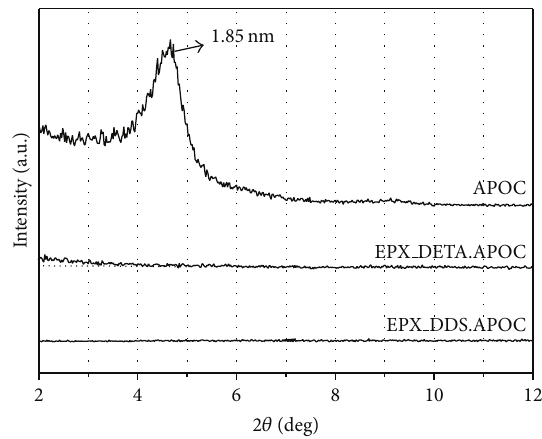
Figure 3: X-ray diffraction patterns of organoclay (APOC) and the nanocomposite containing 1 parts per hundred of organoclay (EPX DDS.APOC) and (EPX DETA.APOC)